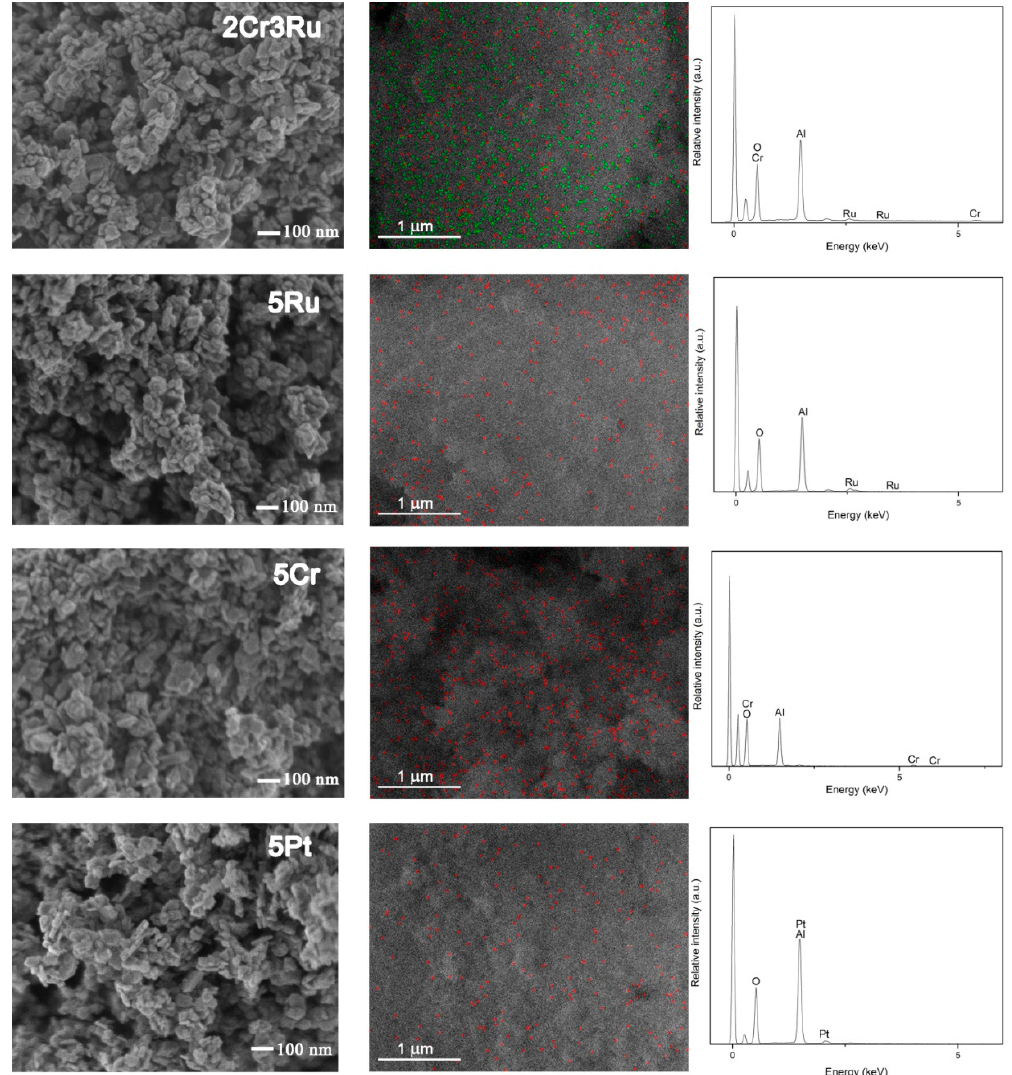
Figure 5. SEM images ( left ), SEM / EDS images ( center ), and EDS spectra ( right ) of fresh 5Pt, 5Ru, 5Cr, and 2Cr3Ru supported on Al 2 O 3 .